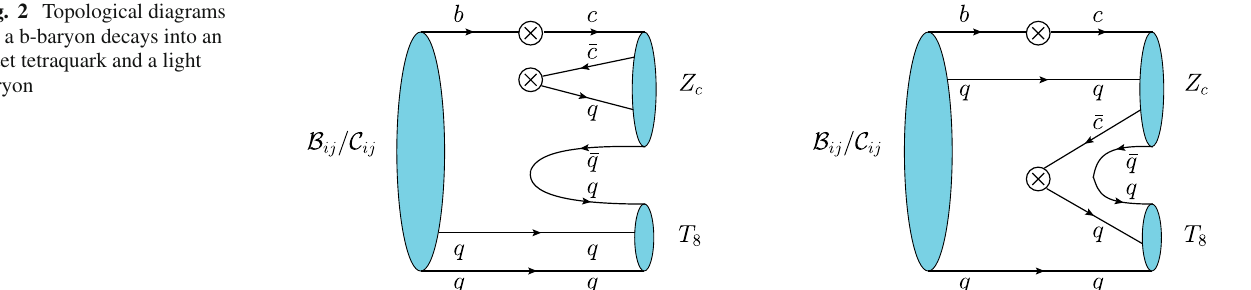
Table 1 Amplitudes for b-baryon (antitriplet) decays into a tetraquark and a light baryon